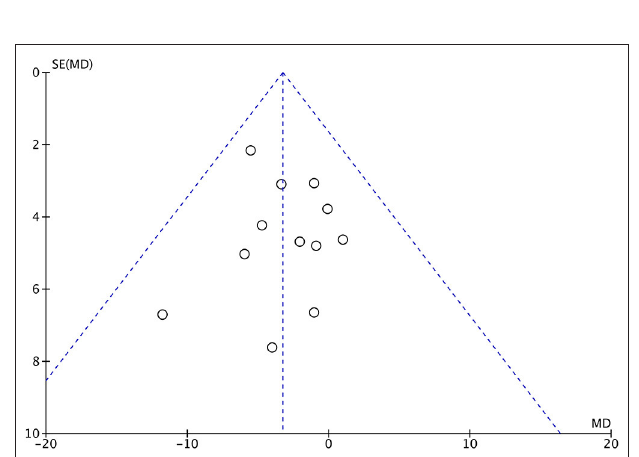
FIGURE 7 | Leave-one-out forest plot for the augmentation index.